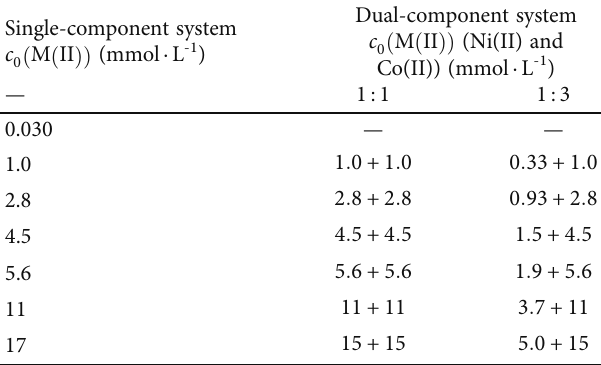
Table 1: Initial concentrations of metal ions in the prepared single- and dual-component systems (molar ratio Ni(II) :Co(II) of 1: 1 and 1: 3) for the di ff erent adsorption experiments. Single-component system